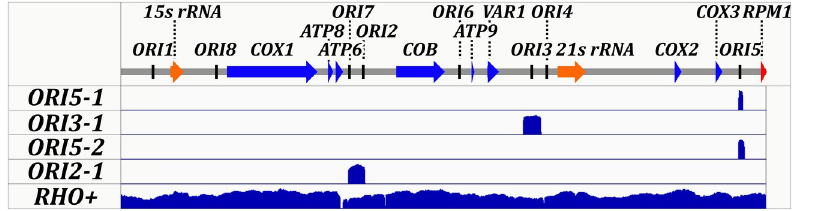
Fig 1. Generation and Characterization of HS Alleles. Mitochondria DNA from HS1b ( ORI5-1 ), HS3b ( ORI5-2 ), HS6a ( ORI3-1 ), HS11b ( ORI2-1 ), and rho+ control cells was sequenced using pacific biosciences sequencing technology and mapped back to reference genome. Reads from HS ORI5-1 mapped to base pairs 82,101 to 82,615 of the wild type reference genome. HS ORI3-1 mapped to 53,495 to 55,836. HS ORI5-2 mapped to 82,095 to 82,817. HS ORI2-1 mapped to 30,305 to 32,497. Scale bar ranges are 0 to 1619 for HS ORI5-1 , 0 to 1474 for HS ORI5-1 , 0 to 1111 for HS ORI3-1 , 0 to 660 for HS ORI2-1 and 0 to 305 for rho+